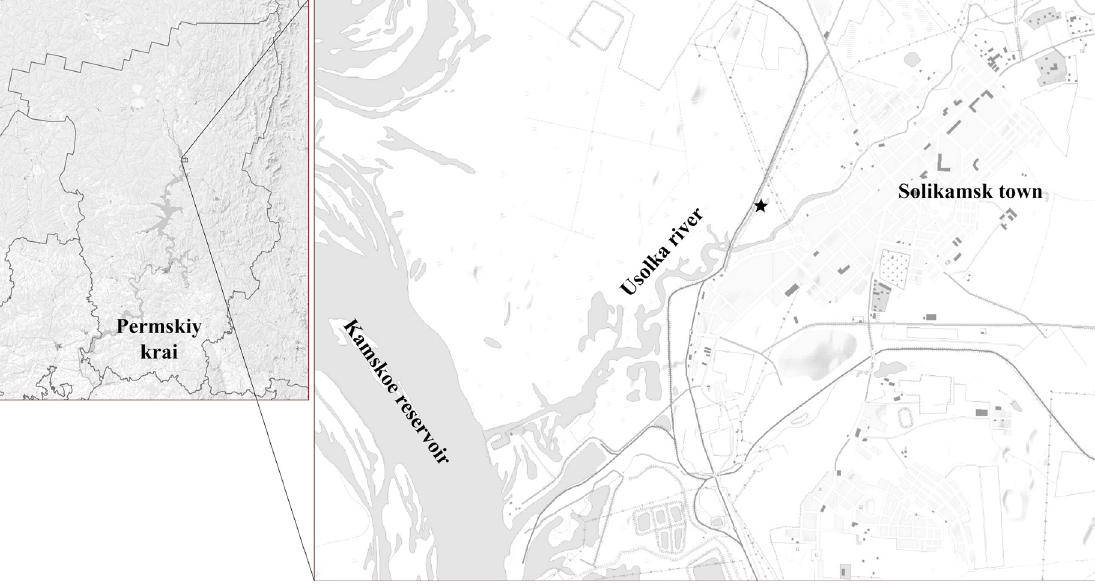
Fig. 1. Map of the study area; created using SASPlanet